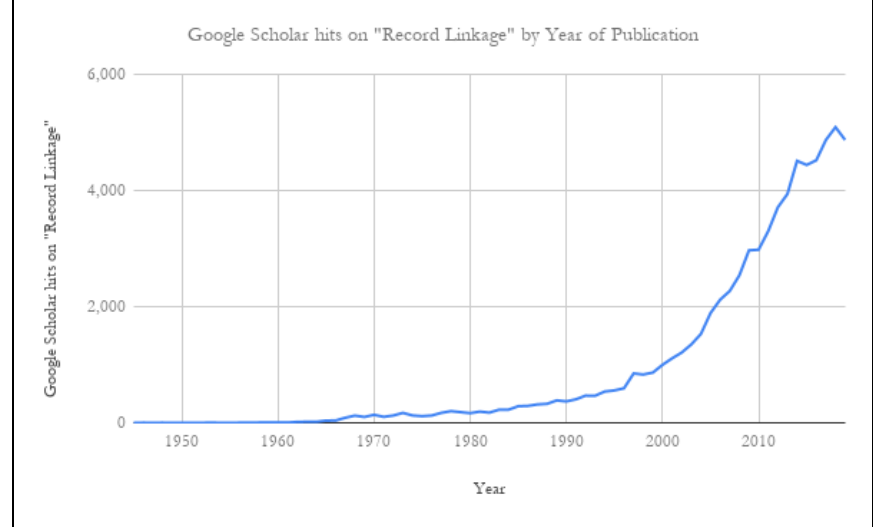
Figure 1. Publications related to record linkage on Google Scholar, by year of publication. Data obtained 9 August 2019 for years prior to 2019; data obtained 31 December 2019 for 2019.